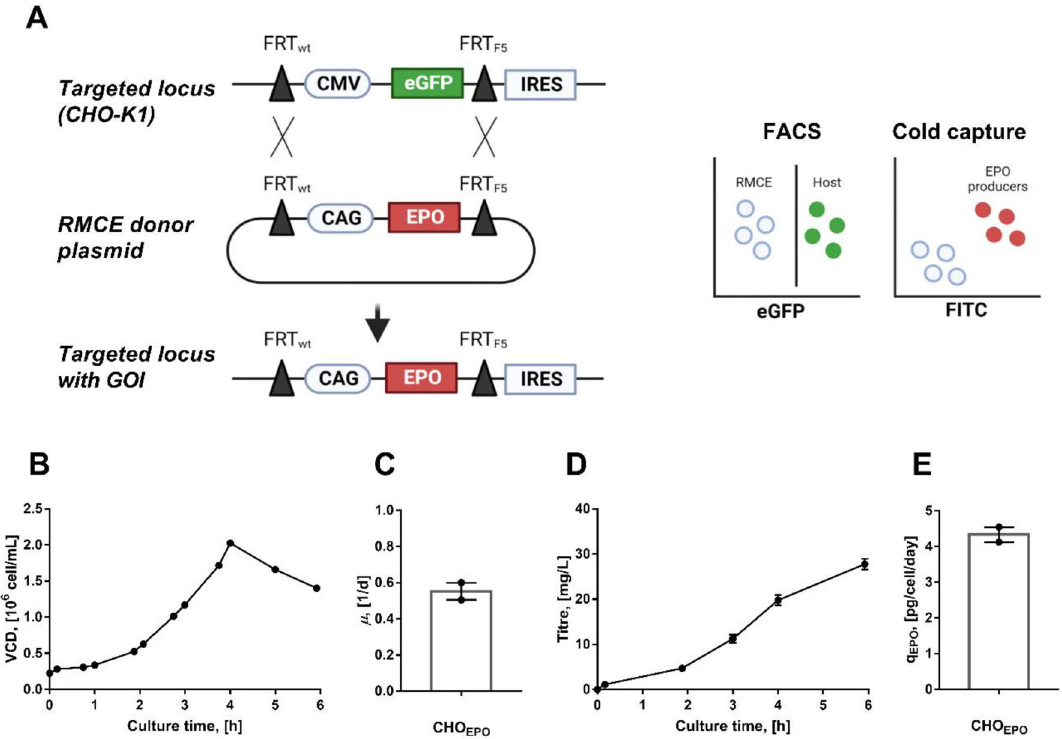
Figure 1. Generation of an EPO producing CHO cell line using recombinase-mediated cassette exchange (RMCE) system. ( A ) Overview of the RMCE-based cell line development. A CHO-K1 host cell line with an integrated, FRT and F5 flanked CMV-eGFP cassette 24 was used as a master host. The master host was transfected with an RMCE donor plasmid (encoding for EPO) together with a plasmid encoding Flp recombinase for a site- specific recombination between FRT and F5 sites, respectively. In the resulting cell line the CAG-EPO cassette is integrated in the target locus. Dual FACS strategy was used for selecting targeted, eGFP-negative cells and FITC-positive cells for EPO antibody-based cold capture. ( B ) Viable cell density. ( C ) Cell-specific growth rate. (D) EPO titre profile. (E) Cell-specific productivity. Experimental values represent the mean of two biological replicates ± MYC overexpression, an improvement that has previously observed in other CHO cell lines 11 . In terms of EPO production, we found that CHOCX EPO cell lines had significantly higher EPO titres compared to the other cell lines, with an increase of 2.5-fold on average EPO production compared to the original CHO EPO (Fig. 2D). We also observed a slight increased cell-specific productivity in the XBP1s overexpressing cell lines (both CHOX EPO and CHOCX EPO ), although these differences were not statistically relevant (Fig. 2E). This discrepancy between the EPO titres and q P in the CHOCX EPO cells might be explained by the increased IVCCs due to MYC overexpression. We also evaluated culture metabolites (glucose, lactate, glutamine and ammonia) and calculated their cell- specific rates of consumption/production to compare the impact of MYC and XBP1s overexpression on cell metabolism (Fig. 2F–K). We found that MYC overexpression had a great influence on the metabolic behaviour of our cells. The CHOCX EPO cells increased their lactate production rates (q LAC ), despite of maintaining similar glucose consumption rates (q GLC ) compared to the control. Additionally, we observed that the CHOCX EPO cells increased glutamine consumption rates (q GLN ), without significantly varying ammonia production rates (q NH3 ) compared to the control. The increased consumption of glutamine and production of lactate were associated with MYC overexpression, as the CHOC EPO cells also presented similar increase in glutamine and lactate metabolism. These data suggested that most of the overproduction of lactate in MYC overexpressing cells resulted from the high consumption of glutamine. The glutamine-driven lactate production is a phenomenon previously reported in CHO cells, in which a significant part of the glutamine is metabolised in the TCA cycle (oxidised to malate) and then converted into pyruvate in the cytosol 28,29 . Gene expression of recombinant EPO, MYC and XBP1s and its relationship to product titres and cell proliferation. Next, we evaluated whether improvements in EPO production and cell growth in MYC and XBP1s transfected cells were associated with variations in recombinant gene expression (Fig. 3). We confirmed strongly increased mRNA expression of MYC and XBP1s in the respectively engineered cell lines (Fig. 3B,C). However, we only found minor, statistically non-significant differences in EPO mRNA expression, indicating that the TF did not increase CAG promoter driven EPO transcription (Fig. 3A). To evaluate the influence of the targets (i.e., EPO, MYC and XBP1s) on EPO production and cell growth, we performed statistical Pearson’s correlations between the normalised EPO titres or IVCC and the mRNA